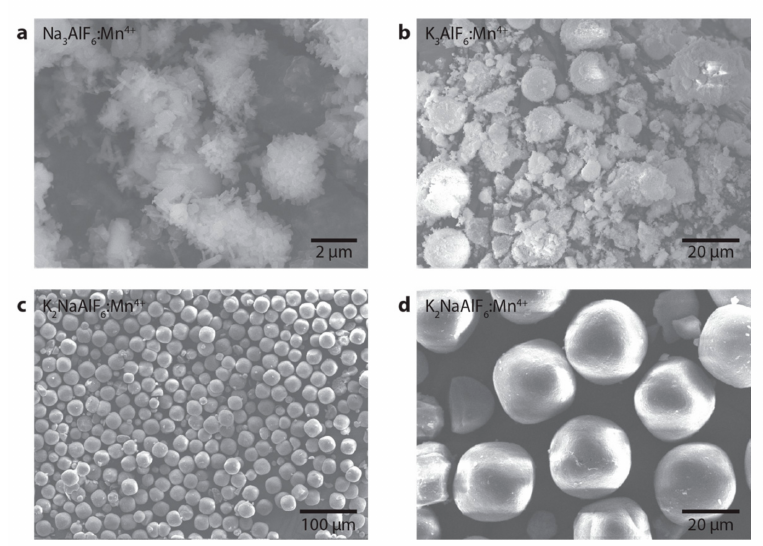
Figure 2. Representative scanning electron microscopy (SEM) images of ( a ) Na 3 AlF 6 :Mn 4+ (0.4%) phosphor particles; ( b ) K 3 AlF 6 :Mn 4+ (1.2%) phosphor particles and ( c , d ) K 2 NaAlF 6 :Mn 4+ (0.9%) phosphor